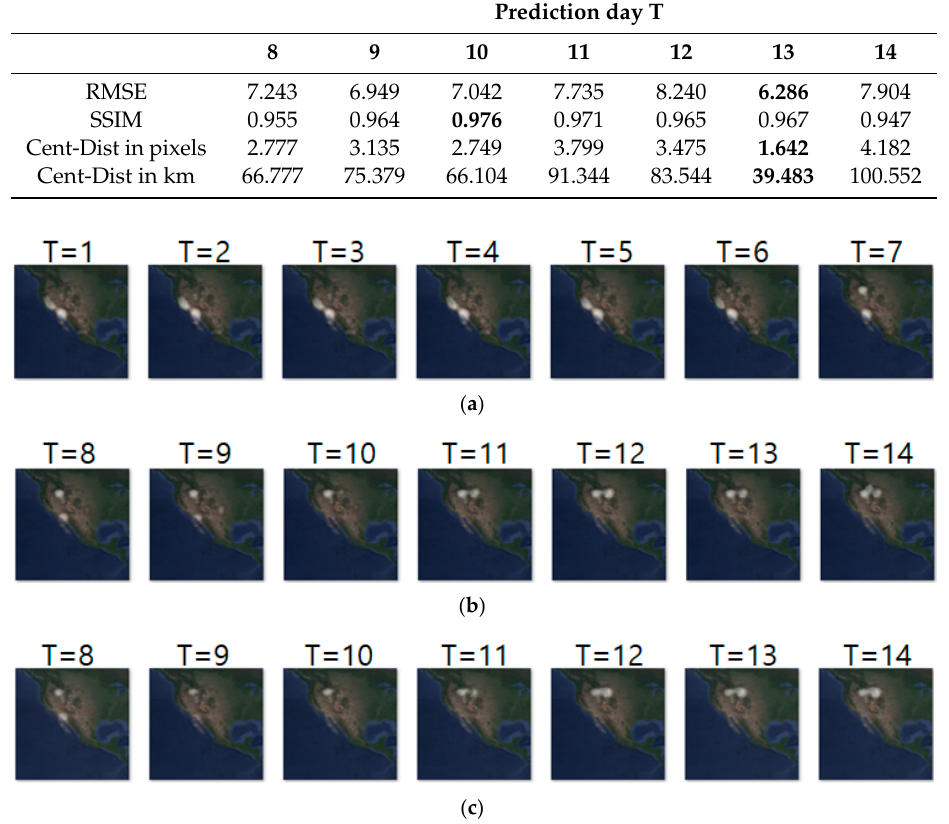
Figure 11. Movement prediction result–( a ) input sequence; ( b ) ground truth; ( c ) predicted sequence.